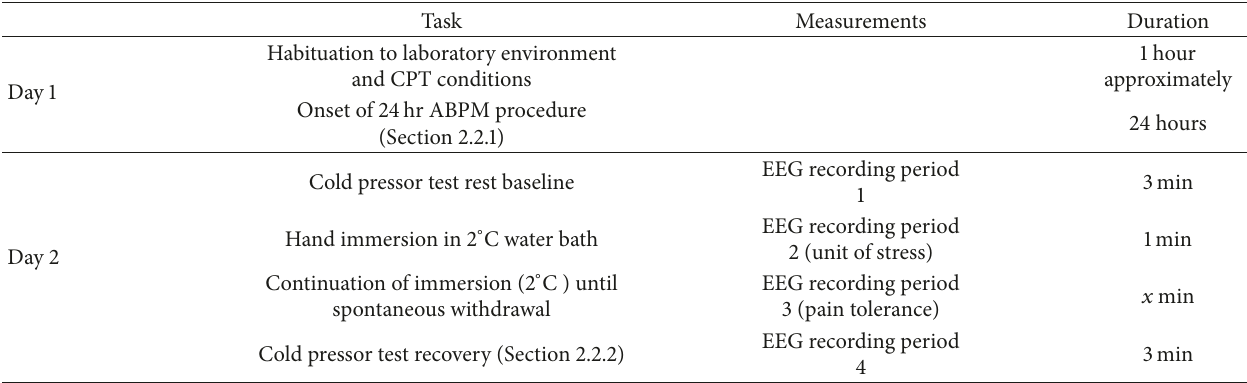
Table 1: Outline of experimental